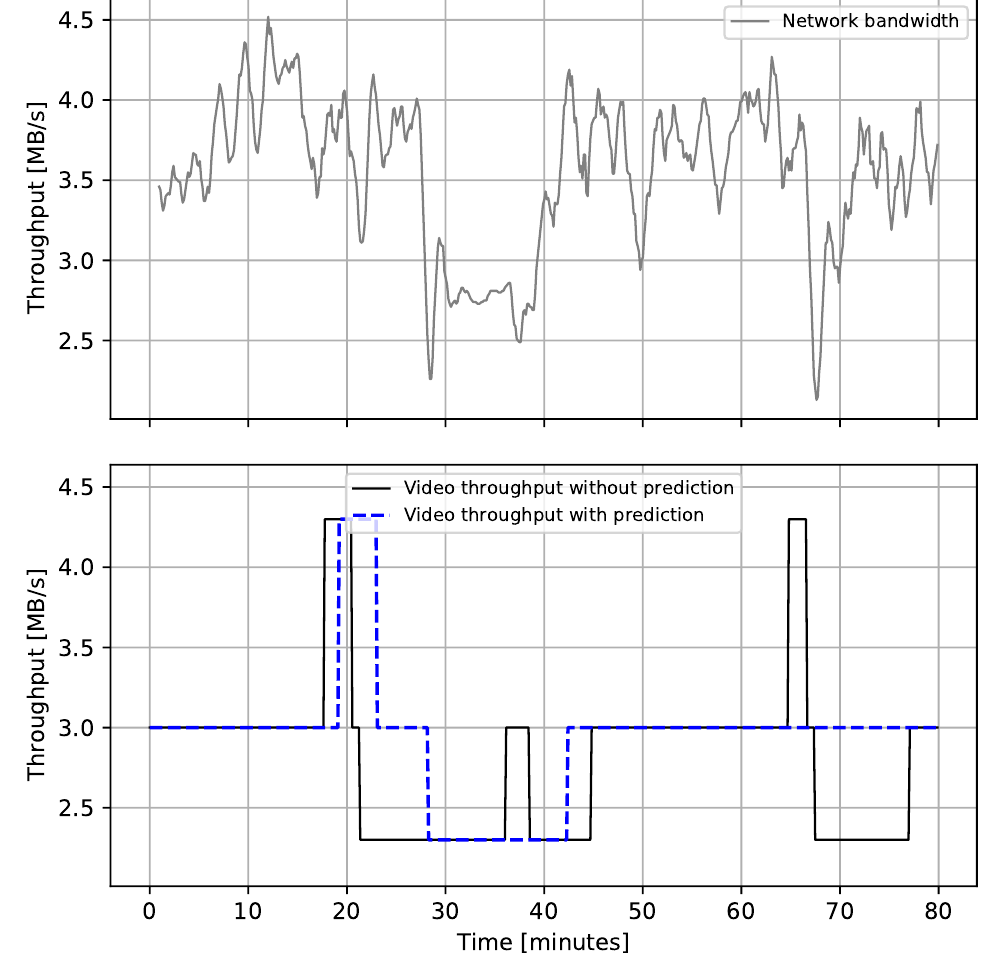
Figure 12. Performance of MSS algorithm without and with support of traffic prediction. Throughput prediction eliminates some of the video bit rate drops observed at the beginning, end and approxi- mately the 20th min of the trace. However, as the prediction sometimes overestimates the throughput, the bit rate unnecessarily switches to a higher level at about the 20th min of the